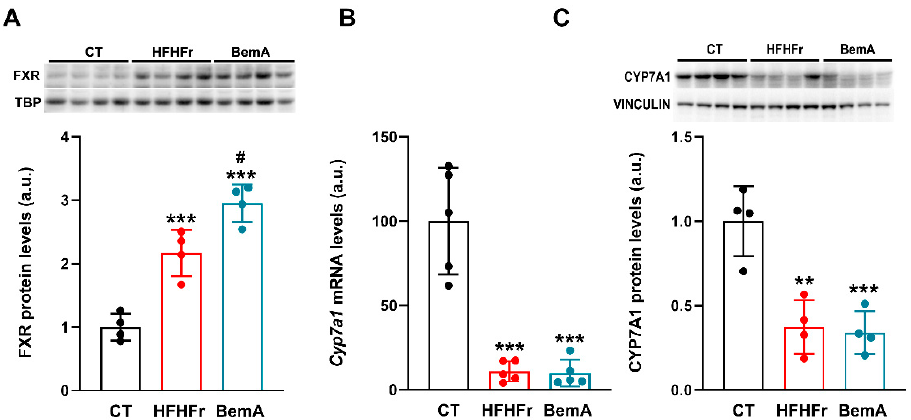
Figure 3. Effect of Bempedoic acid on nuclear FXR protein levels and Cyp7A1 expression in liver samples. Bar plots show ( A ) liver FXR protein levels in nuclear extracts from control (CT), high-fat high-fructose (HFHFr), and bempedoic acid (BemA)-treated rats. The results are expressed as the mean ± SD of four pooled samples, obtained by mixing equal amounts of tissue from two rats, for each condition. ( B ) Bar plots show mRNA and ( C ) protein levels of Cyp7A1 in liver samples from CT, HFHFr, and BemA rats. The results are expressed as the mean ± SD of five samples (mRNA) or four pooled samples (WB), obtained by mixing equal amounts of tissue from two rats, for each condition. On the upper side of the figure, representative western blot bands corresponding to the three different study groups are shown. a.u.: arbitrary units. Data were analyzed by one-way ANOVA followed by Tukey’s post-hoc test. ** p < 0.01, *** p < 0.001 vs. CT; # p < 0.05 vs. HFHFr.